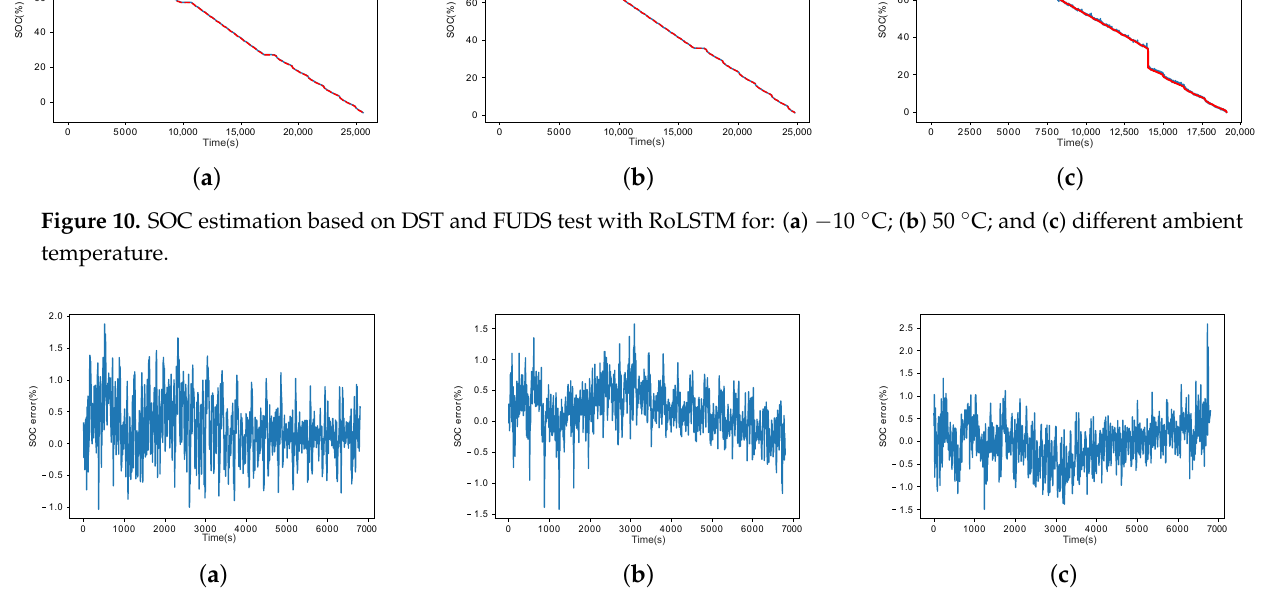
Figure 11. SOC estimation error based on DST and FUDS test with RoLSTM for: ( a ) − 10 ◦ C; ( b ) 50 ◦ C; and ( c ) different ambient